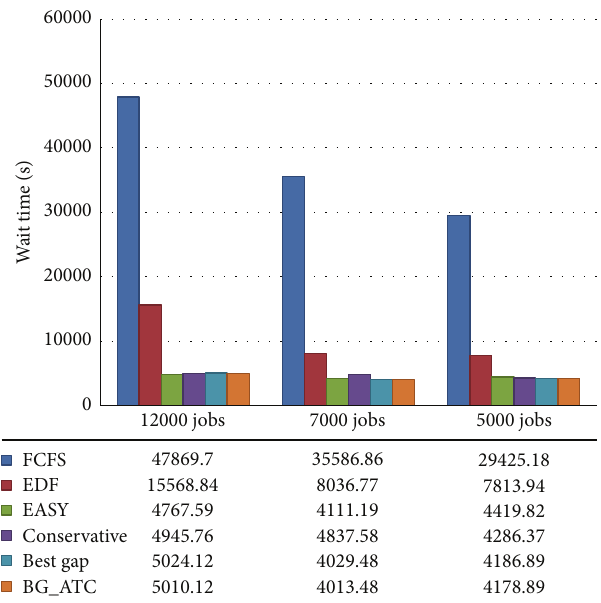
Figure 7: Makespan comparison on blue workload.